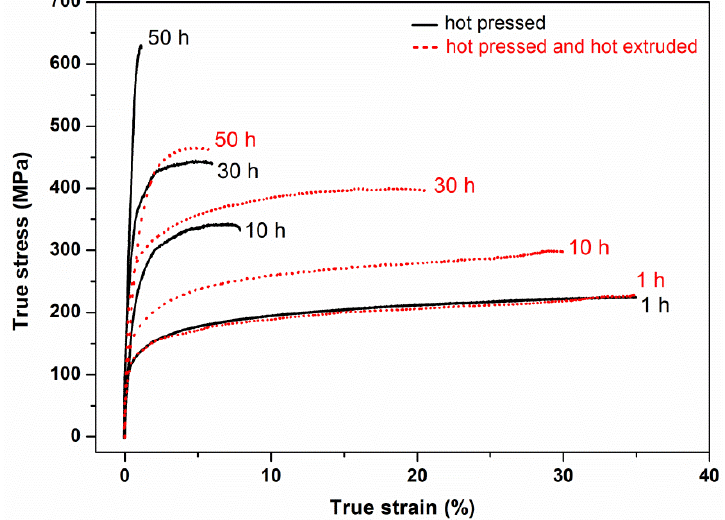
Figure 8. Room temperature compression true stress-true strain curves of the consolidated samples obtained from 1-, 10-, 30- and 50-h milled powders: ( ▬ ) hot pressed and (▬) hot pressed and hot extruded composites. Table 1. Mechanical properties of Al metal matrix composites (MMCs) reinforced